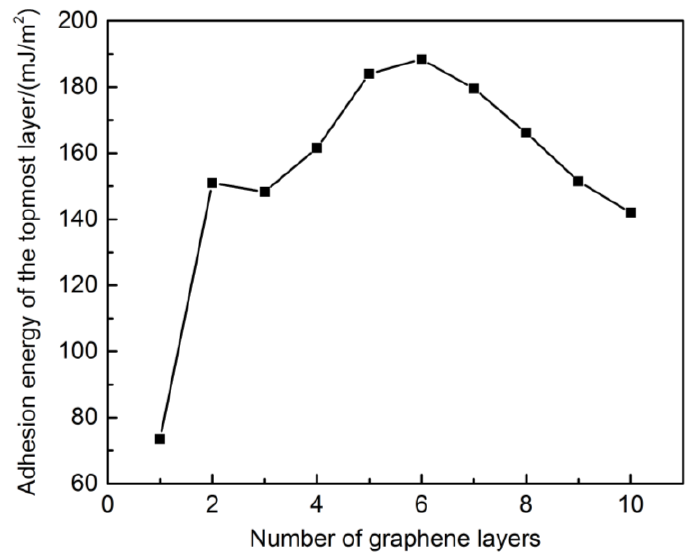
Figure 17. The adhesion energies required to exfoliate the topmost layer of graphene for different numbers of graphene layers.